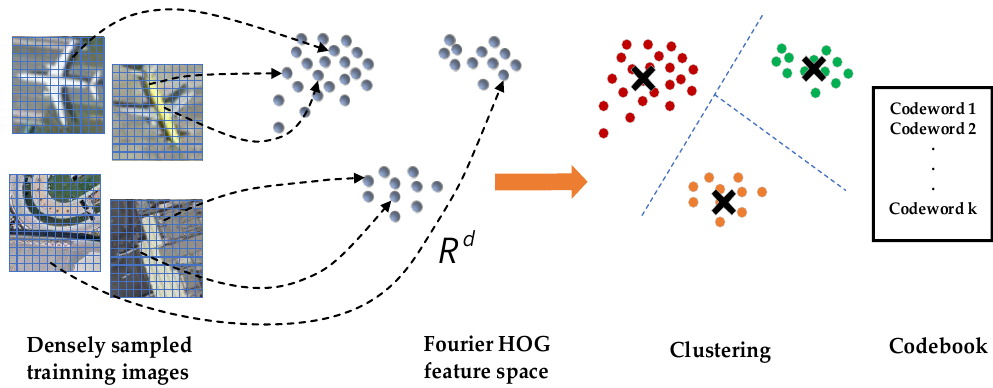
Figure 8. Illustration of the codebook generation in the VLAD representation.